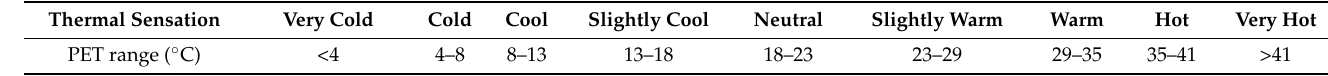
Table 3. Thermal sensations and corresponding PET